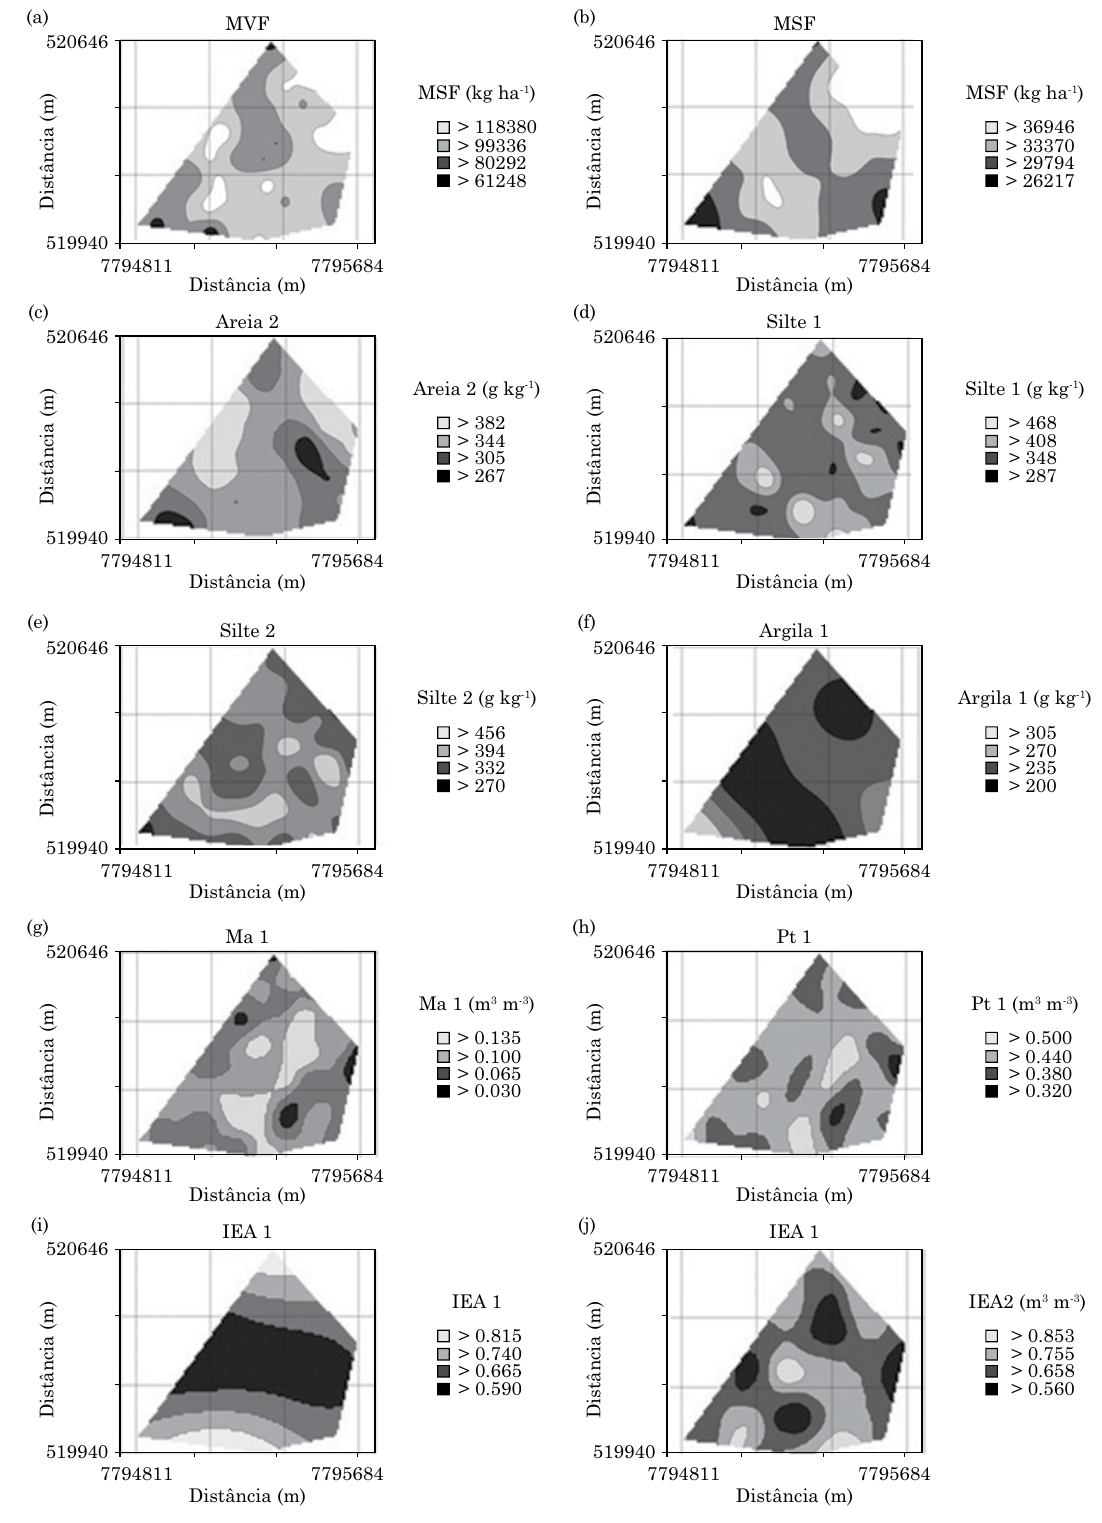
Figura 1. Mapas de krigagem simples para produtividade de sorgo forrageiro e de atributos físicos de um Planossolo Hidromórfico. Atributos de planta (MVF: produtividade de matéria verde de forragem e MSF: produtividade de matéria seca de forragem) e atributos físicos do solo (Ma: macroporosidade, Pt: porosidade total e IEA: índice de estabilidade de agregados) avaliados nas camadas 1 (0,00-0,10 m) e 2 (0,10-0,20